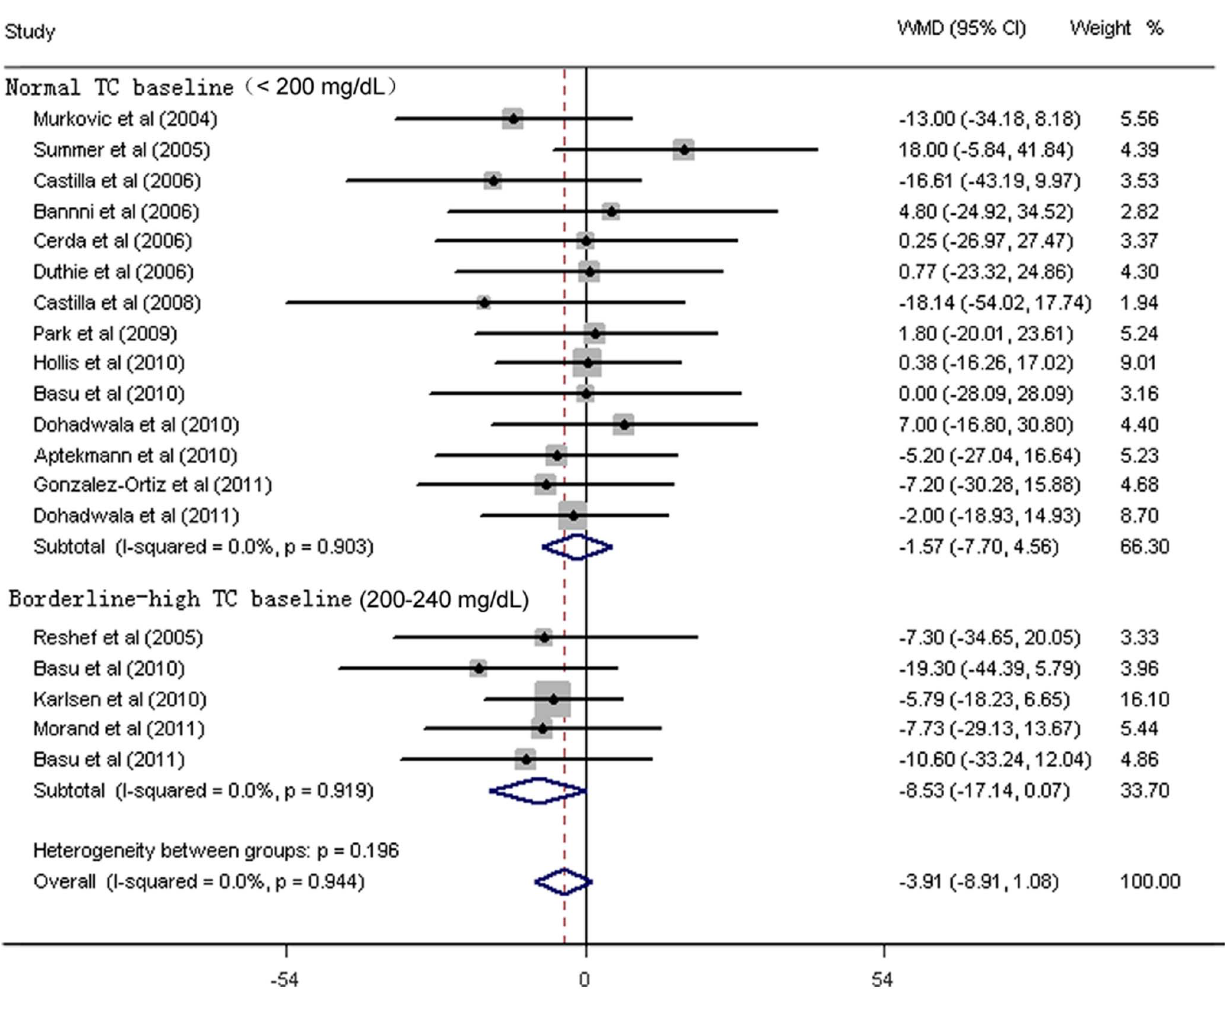
Figure 2. Meta-analysis of effects of fruit juice on total cholesterol (TC) concentrations. The result was obtained from a fixed-effects model. Sizes of data markers indicate the weight of each study in this analysis. The basis of classification of TC is referred to the National Cholesterol Education Program guidelines, Adult Treatment Panel III. WMD, weighted mean difference.